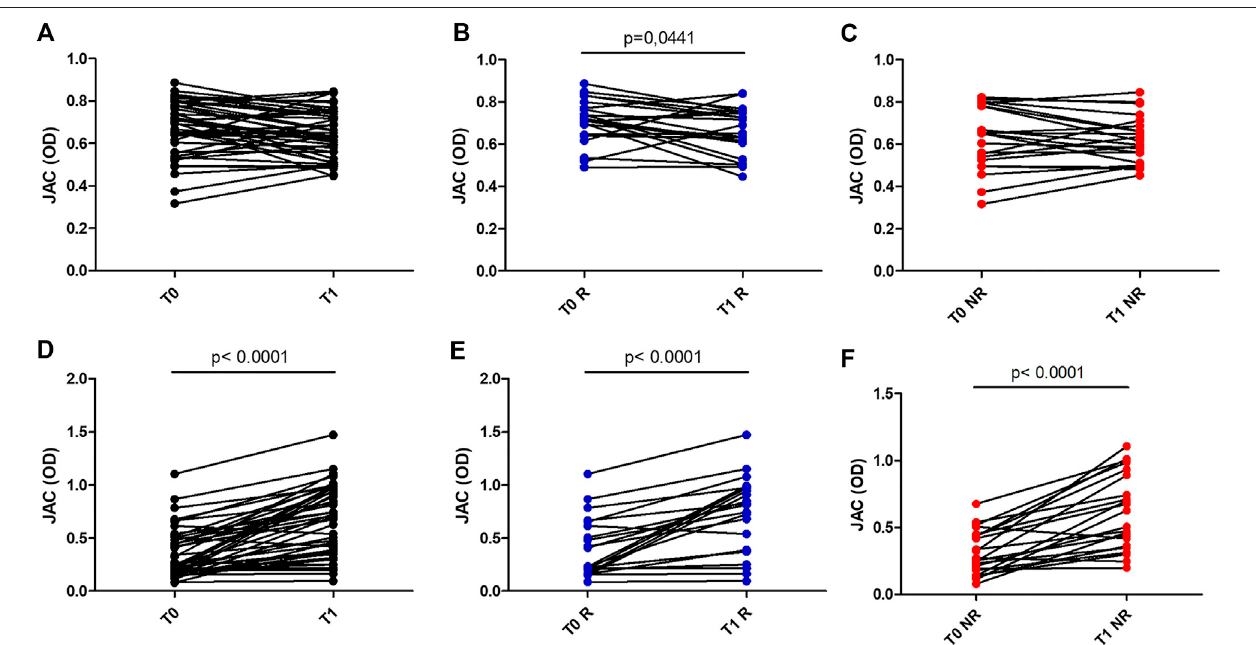
FIGURE 1 | JAC af fi nity for IgG complex at baseline (T0) and after anti-TNF therapy (T1), expressed as Optical Density (OD). A,B,C: coating with Protein A in all patients (A) , in Responders (B) and Non Responders (C) . D,E,F: coating with Fab anti Fab IgG in all patients (D) , in Responders (E) and Non Responders (F) . All Responders (R) dots were in blue, All Non Responders (NR) dots were in red.